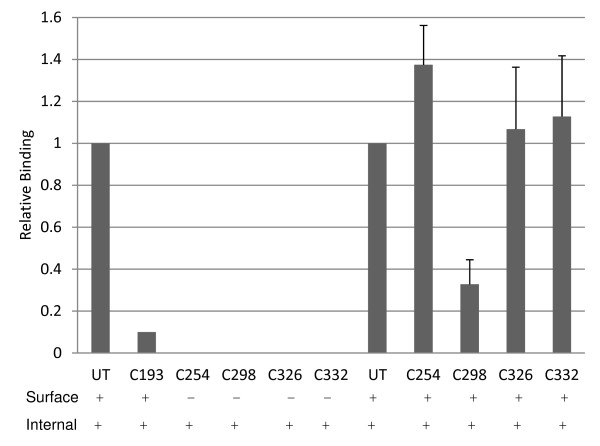
Four disulphide bonds in PkNBPXb are important for expression on the surface of COS cells. The N-terminal domain of PkNBPXb contains five cysteine residues (C193, C254, C298, C326, C332). Using site directed mutagenesis, all five residues were individually mutated to glycine and all but C193 were found to be required for binding to erythrocytes. The glycine residues present in each construct were mutated back to cysteine residues; these constructs were able to express protein on the surface and also able to bind erythrocytes. Surface and internal expression is indicated with + or – signs.